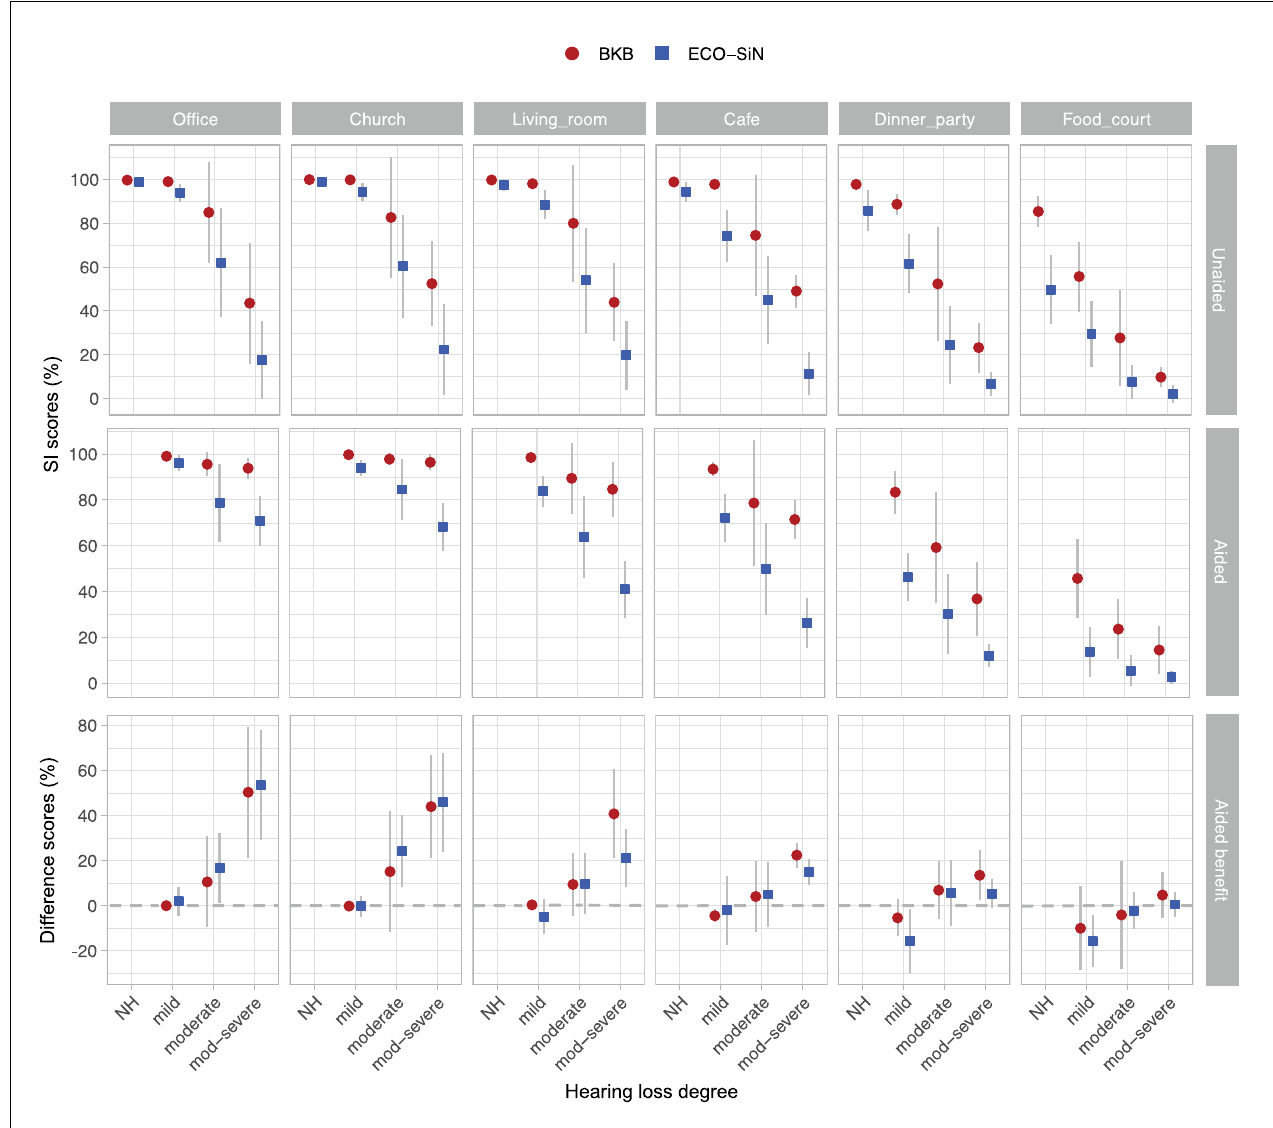
FIGURE 4 | Speech intelligibility (SI) scores obtained with BKB and ECO-SiN sentences. Shown are group means in percent correct (error bars show standard deviations). Top row: unaided listening; middle row: aided listening; bottom row: hearing-aid benefit (difference between aided and unaided scores). Note the different y -axis